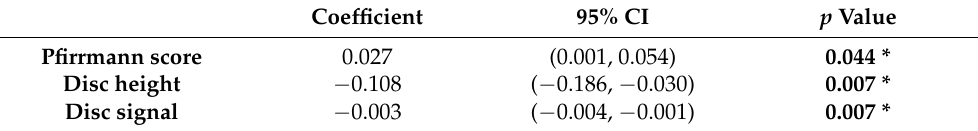
Table 2. Linear regression analysis of various parameters of transitional discs with age in type II